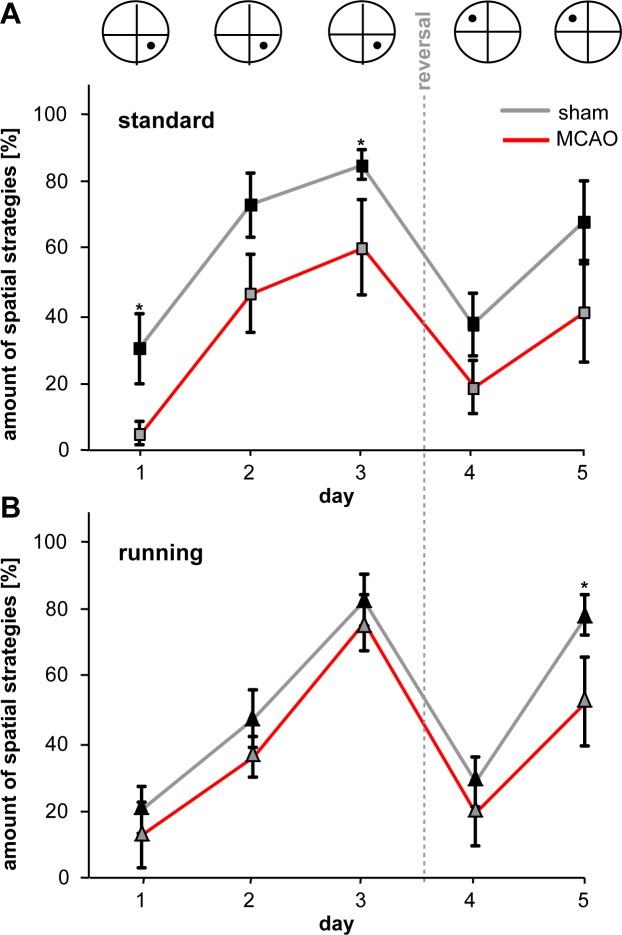
Contribution of pooled hippocampus-dependent search strategies.A/B, Graph depicts percentage of all hippocampus-dependent strategies (direct swim, focal search, directed search) in MCAO- and sham-operated animals either following standard housing (A) or free access to running wheels (B). Graphs represent mean ± SEM. Asterisks indicate significant differences (p < 0.05).